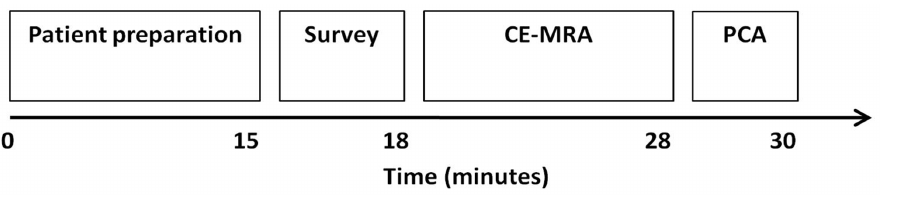
Figure 1. Overview of imaging protocol and the approximate duration of each acquired sequence. Contrast-enhanced MR angiography (CE-MRA) was combined with phase-contrast angiography (PCA) flow MRI. Total MRI examination time, including patient positioning, table movements and MRI scans, was approximately 30 minutes.